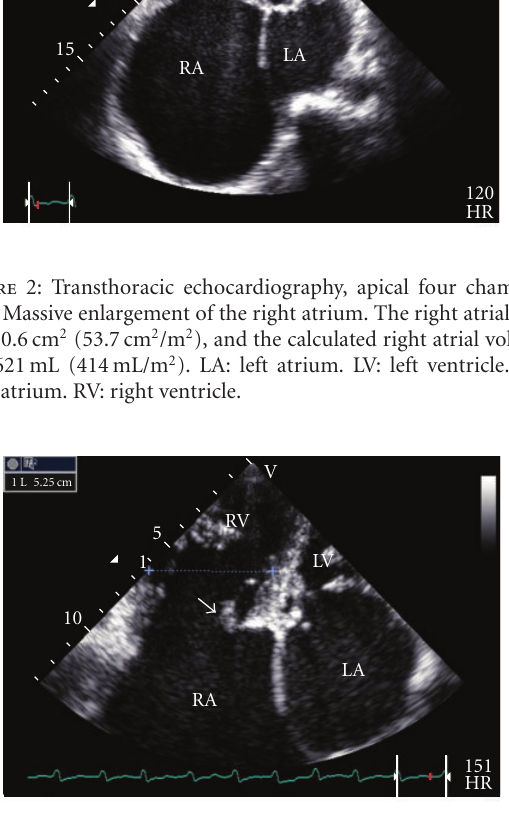
Figure 3: Transthoracic echocardiography, four apical four cham- bers view. Dilatation of the right ventricle (52.5mm, mild diam- eter). The tricuspid valve was thickened and not displaced (white